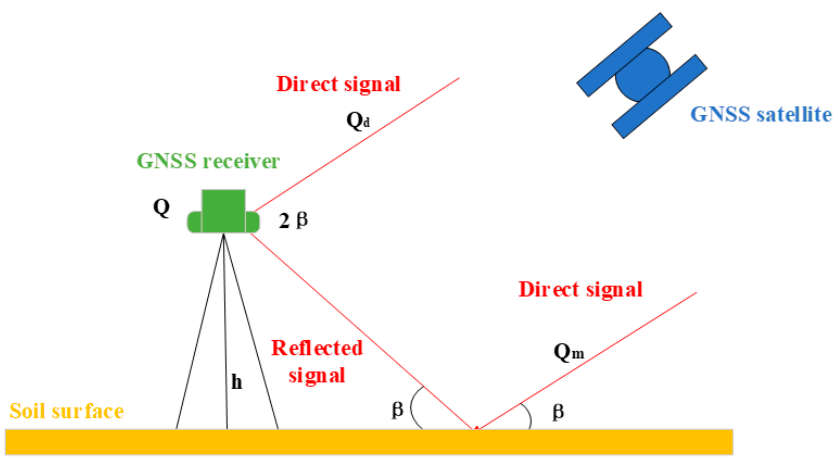
Figure 1. Ground multipath error model.